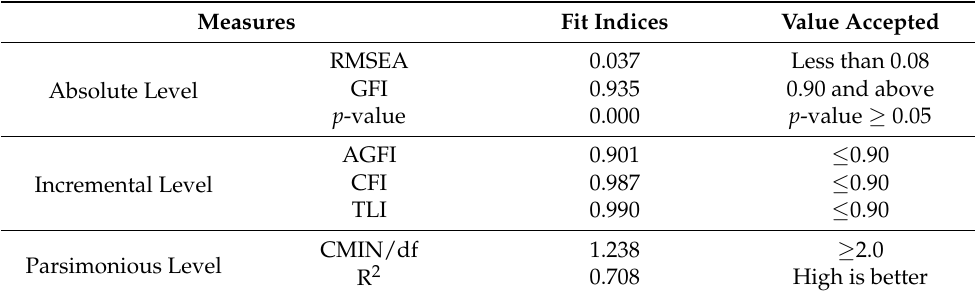
Table 6. Goodness of fit of the hypothesized model.